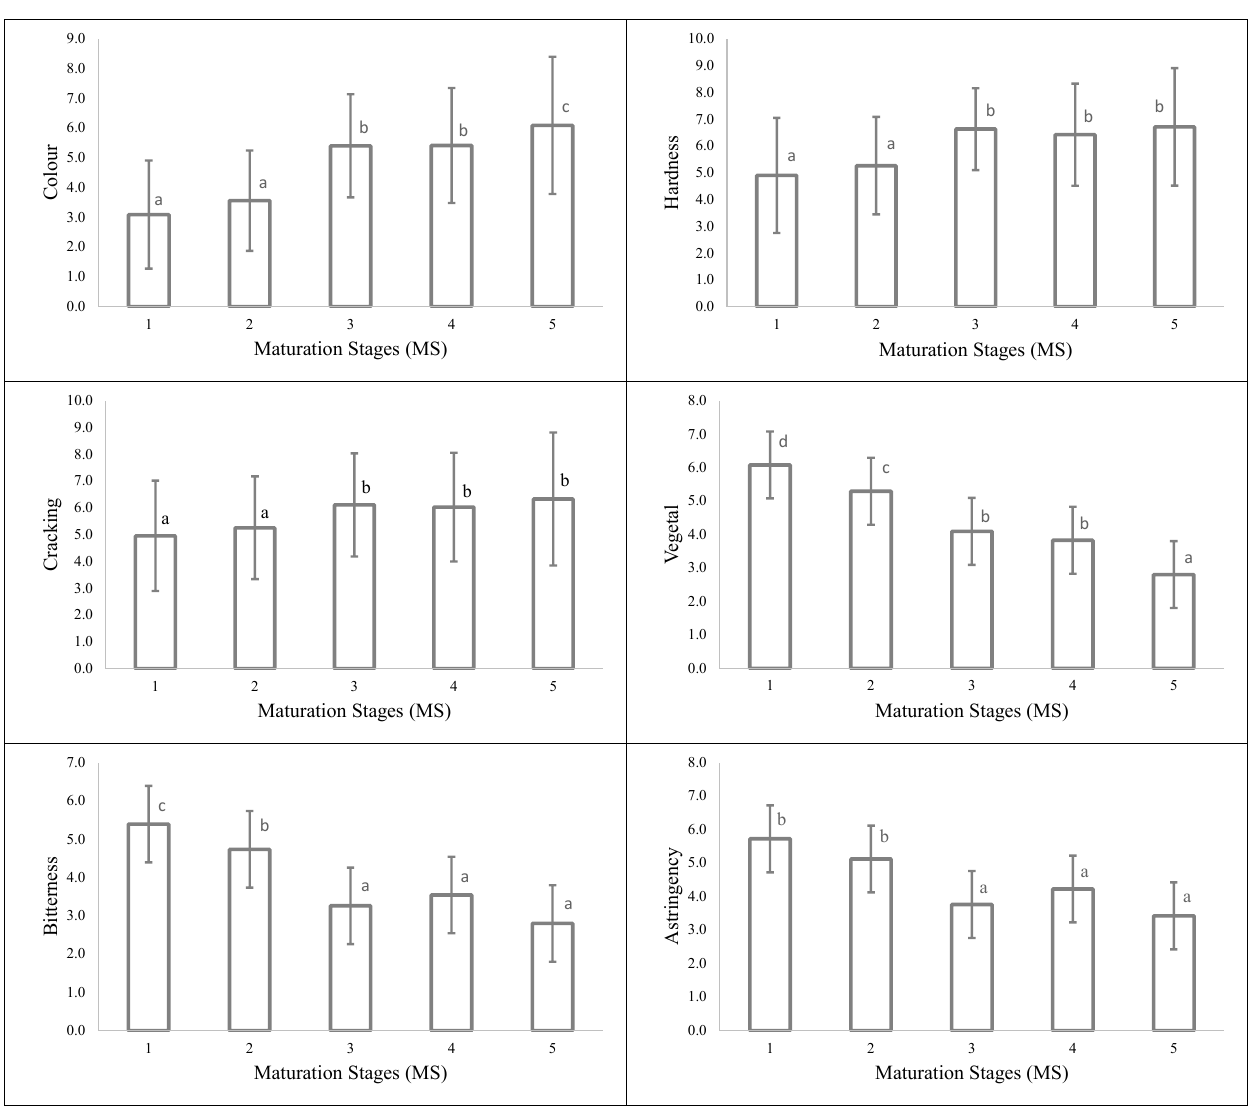
Figure 4. Evolution of seed sensory attributes on a 0–10 scale of all maturity stages (MS). Means and standard deviation. Different letters indicate significant ( p < 0.05) differences according to Student–Newman–Keuls.